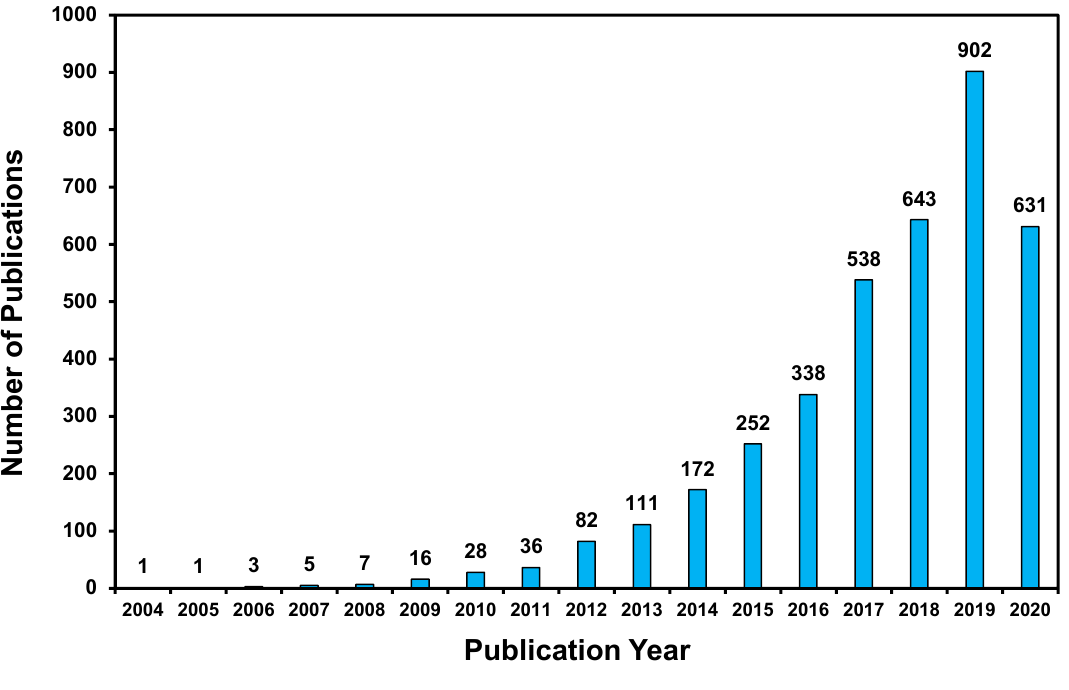
Figure 1. Number of papers in the field of eutectic solvents from 2004 to 2020 (internet search on Scopus, 15 June 2020). Keywords: “eutectic solvents.”